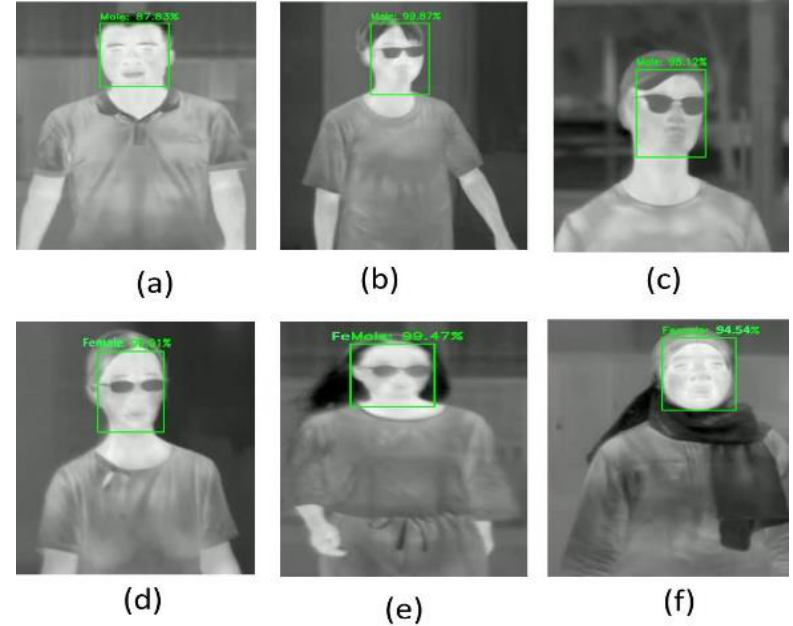
Figure 11. Evaluation test of the real-time face detector and gender classify in different scenarios on the DHU Night dataset. ( a ): Male, regular, ( b ): male with glasses, ( c ): male with glasses and a cap, ( d ): female with glasses and short hair, ( e ): female with glasses and long hair, ( f ): female with a scarf.